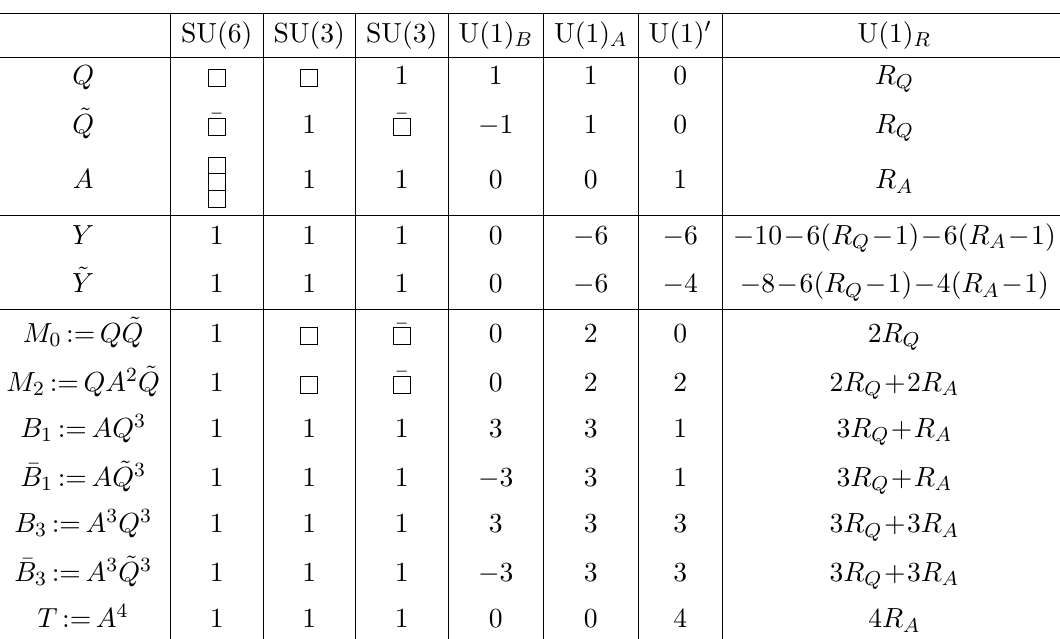
Table 3 . Quantum numbers of 3d N = 2 SU(6) with a three-index